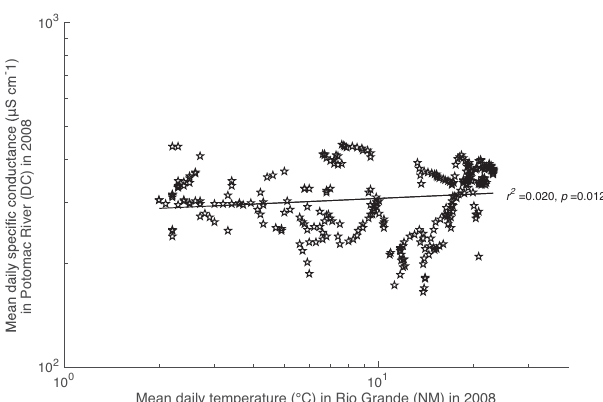
Figure 4. Synthetic data correlation, type X 1 × X 2 vs. X 3 × X 2 , with common parameter X 2 . This spurious correlation results sim- ply because X 2 is common to both